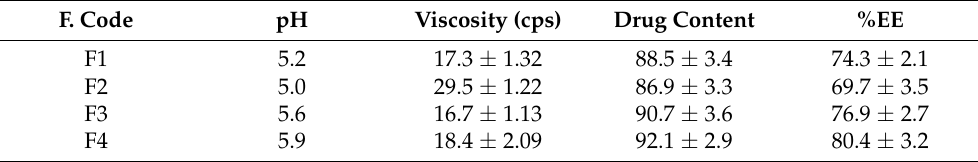
Table 2. pH and viscosity of the formulated emulsions.